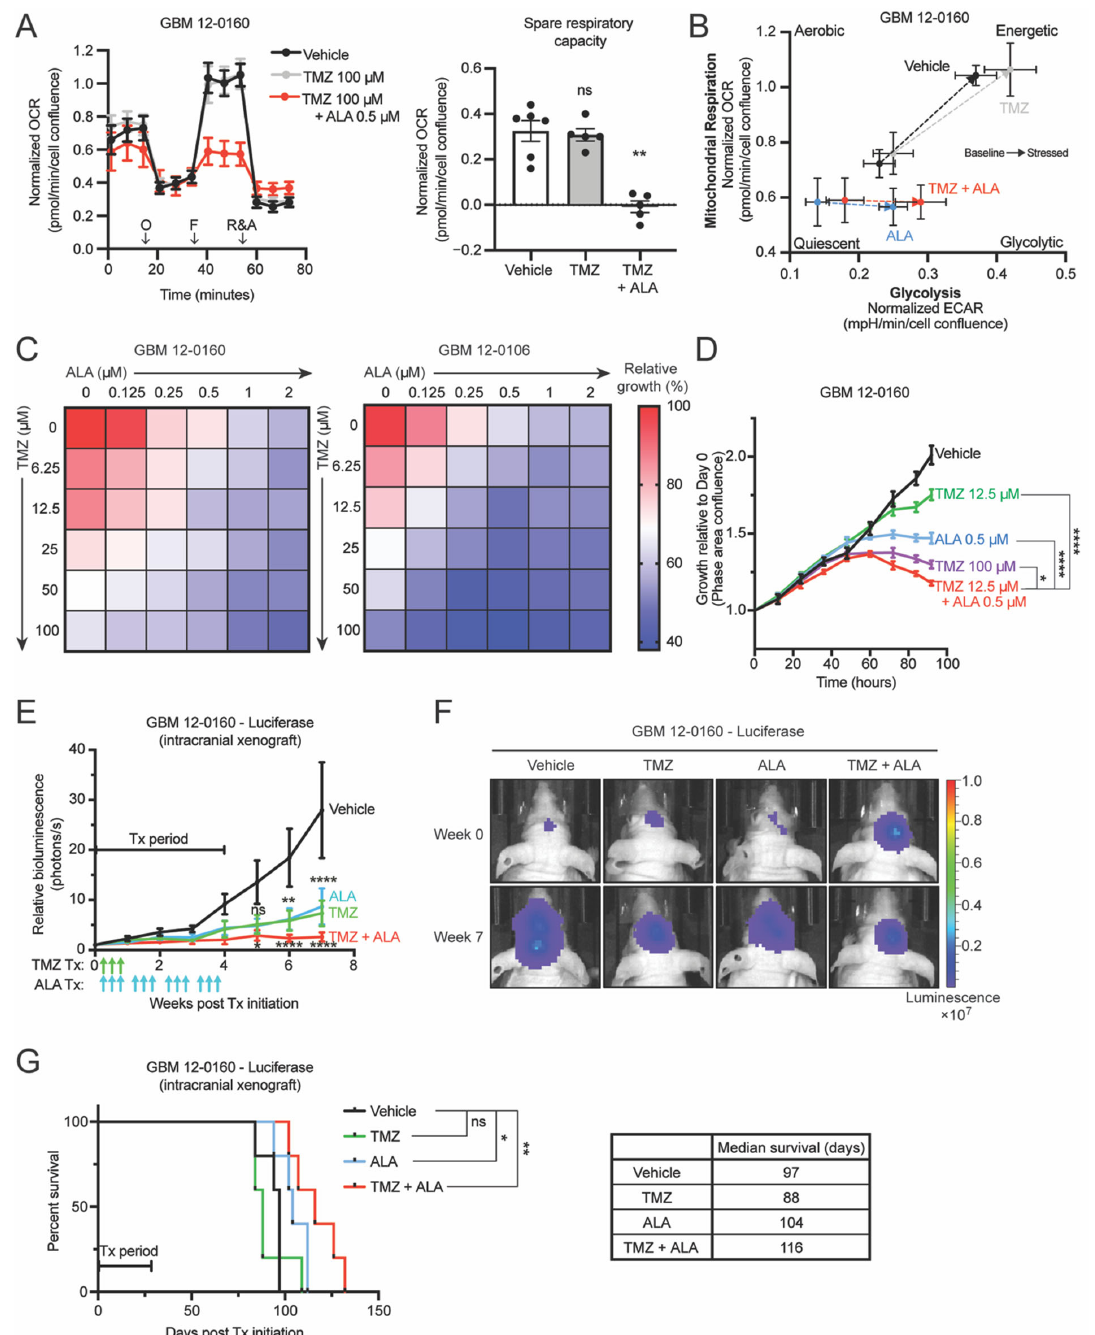
Figure 4. Inhibition of de novo purine synthesis using L-Alanosine (ALA) attenuates MTAP -deficient glioblastoma (GBM) cells’ resistance to TMZ in vitro and in vivo. ( A ) Seahorse XF analysis of GBM 12-0160 shows that 2-week ALA 0.5 µ M-pretreated cells maintain attenuated maximal respiration (left) and abolished spare respiratory capacity (right) when treated acutely (24 h) with TMZ. n = 6 replicates for Vehicle, n = 5 replicates for each other condition. O: Oligomycin, F: FCCP, R&A: Rotenone and Antimycin A. ( B ) Seahorse XF cell energy phenotype analysis shows that ALA 0.5 µ M-pretreated cells (ALA alone and TMZ + ALA) are unable to shift their metabolism toward an “energetic” phenotype to meet induced energy demands. Arrows indicate Baseline to Stressed condition. Stressor compounds: oligomycin (ECAR) and FCCP (OCR). ( C ) Heatmaps show combination effect of TMZ and ALA on growth of two MTAP -deficient GBM cell lines. Growth assayed with Incucyte Live Cell Imaging system, 4 days (percentage confluence). Growth shown relative to Vehicle condition, n = 3